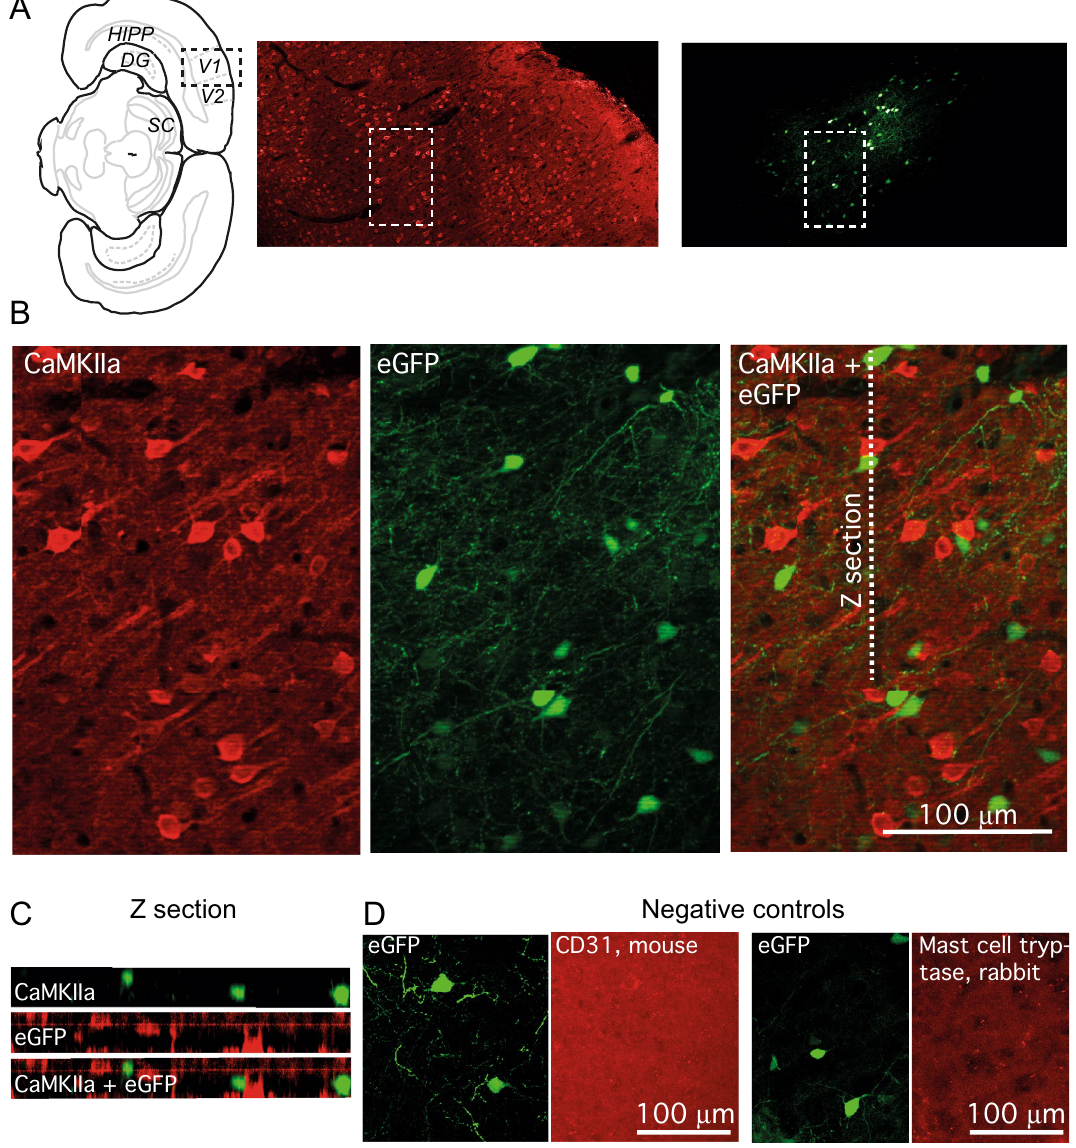
Figure 2. PV promoter excludes the reporter expression in pyramidal neurons. ( A ) Schematic representation of rat brain coronal section with delineated brain areas: V1, visual cortex area V1, HIPP, hippocampus, DG, dentate gyrus. The black dashed line box on the right indicates the approximate location of brain sections shown on the right for CamKIIa antibody (red, middle) and the virus delivered eGFP (green, right). White dashed line box indicate the area shown in ( B ) Fluorescence images of a brain section stained for CamKIIa antibody (left), the virus reporter fluorescence (middle) and merged two images (right). ( C ) A Z section along the dashed line shown in ( B ). The scale is the same as in ( B ). ( D ) Antibodies for CD31 protein (platelet endothelial cell adhesion molecule) were used as a negative control for mouse antibodies while mast cell tryptase antibodies were used as negative control for rabbit antibodies. Note the lack of any cell-specific